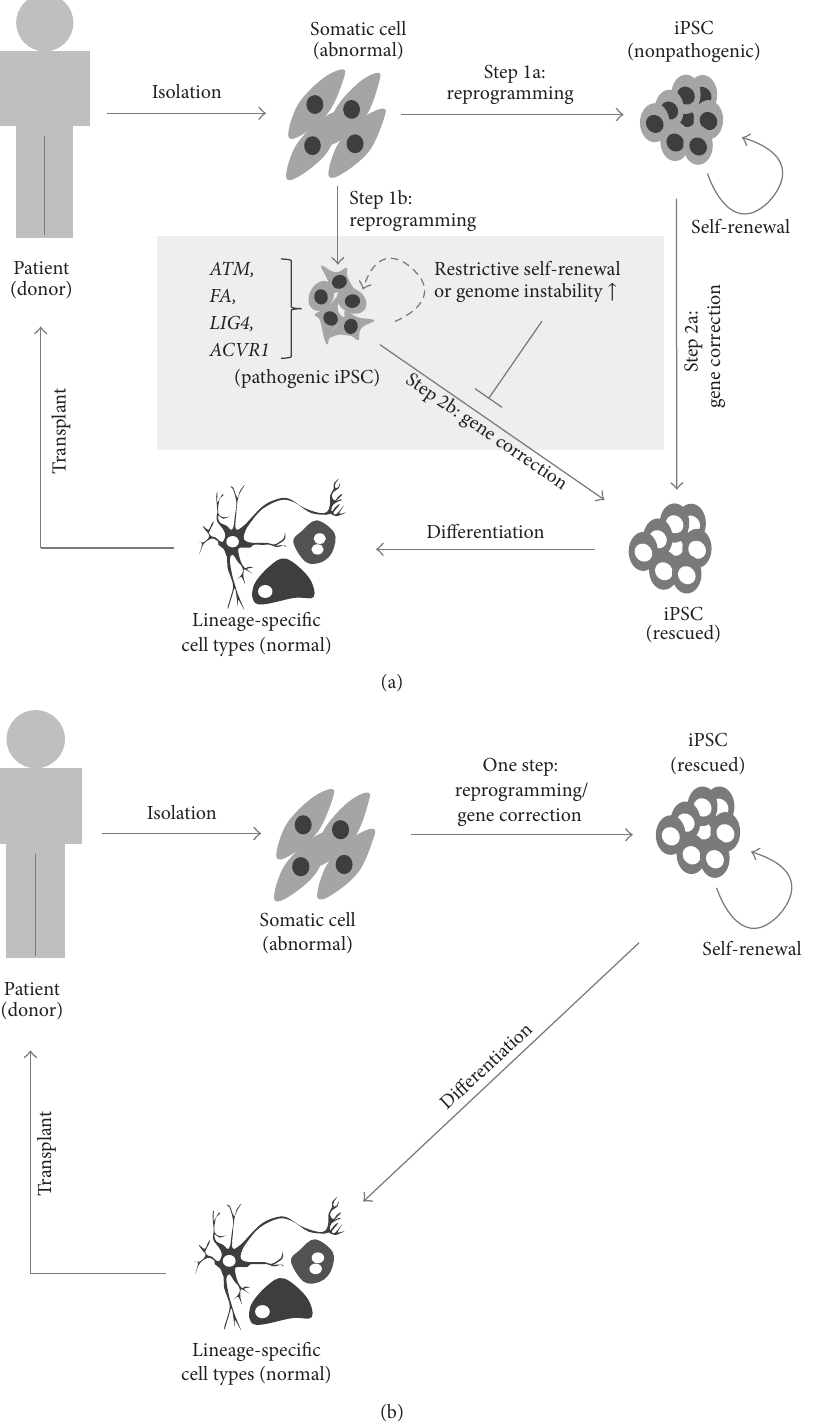
Figure 2: Overview of the combined reprogramming and gene-correction strategy. (a) Current iPSC-based gene-correction approach. Step 1 a: nonpathogenic iPSCs can stably maintain their self-renewal property. Step 1 b: pathogenic iPSCs, derived from cells with mutations in ATM , FA , LIG4 , or ACVR1 , exhibit restrictive self-renewal and a potential rise of genome instability, hampering progress to Step 2 b. Step 2 a: the iPSCs generated from Step 1 a can be subsequently subject to gene correction with various tools such as ZFNs, TALENs, CRISPR/Cas9, or BACvectors.(b)Aone-stepprocessinvolvingsimultaneousreprogrammingandgenecorrection.Gene-correctediPSCsaredirectlyproduced from patient-derived somatic cells, concurrently combining the reprogramming factors and gene-correction